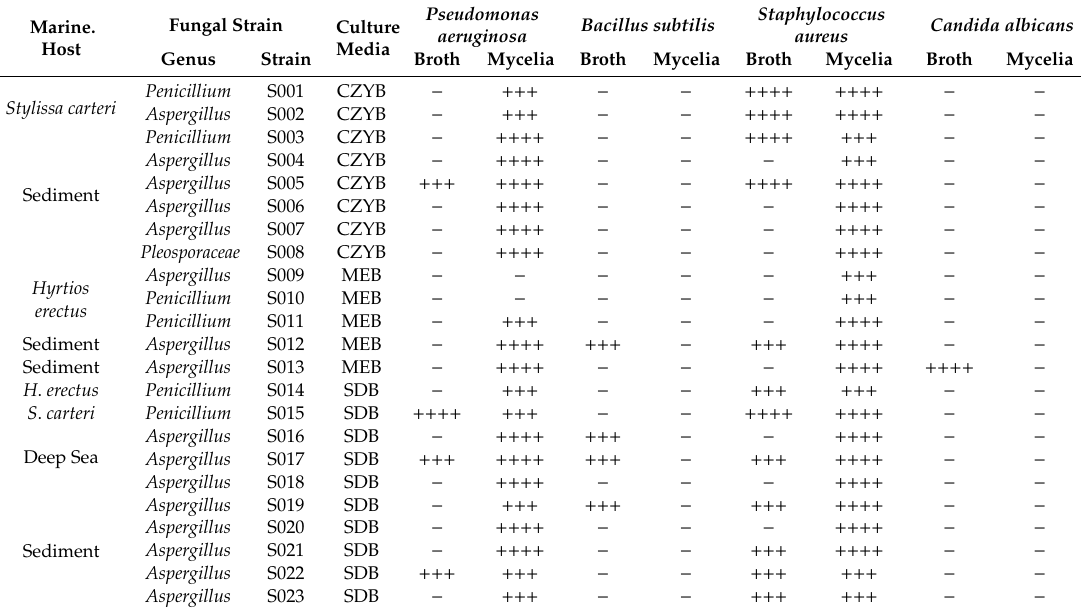
Table 1. Antimicrobial activities of isolated fungal strains’ (S001–S023) crude extracts of both fermentation broth and